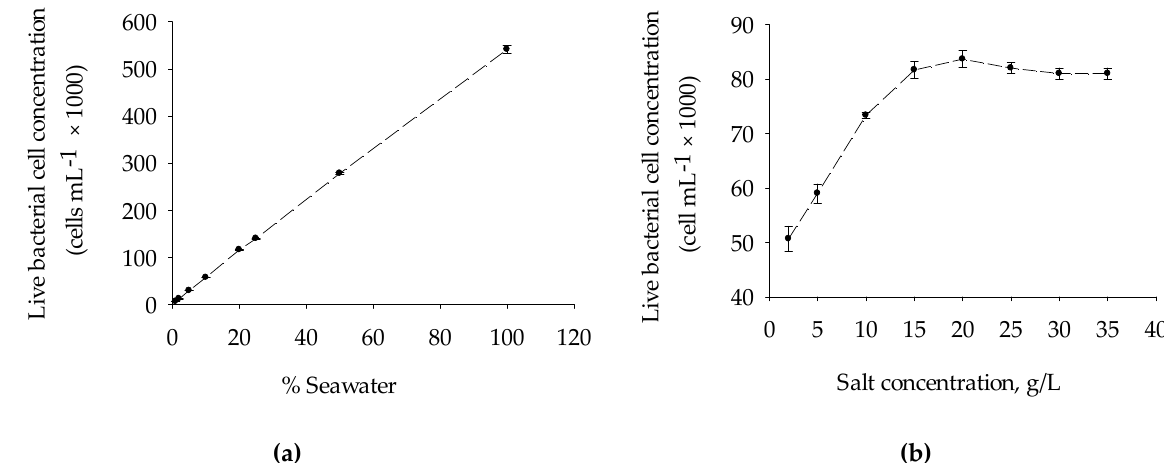
Figure 3. ( a ) Reproducibility and precision of flow cytometry for measuring live bacterial cell concentration in seawater sample and ( b ) bacterial live cell enumeration by FCM after inoculation of the same concentration seawater bacteria (collected from North seawater) to the ASW prepared at different concentrations (0–35 g/L) by varying the concentration of Na + and Cl - (Table 2).